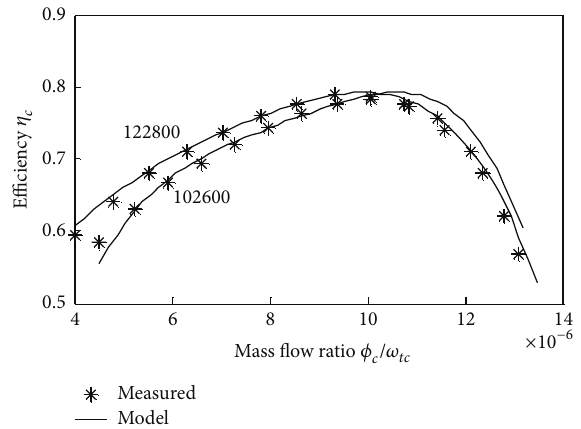
Figure 8: Efficiency model in polynomial form at stationary engine conditions (turbo speeds, 122800 rpm and 102600 rpm).